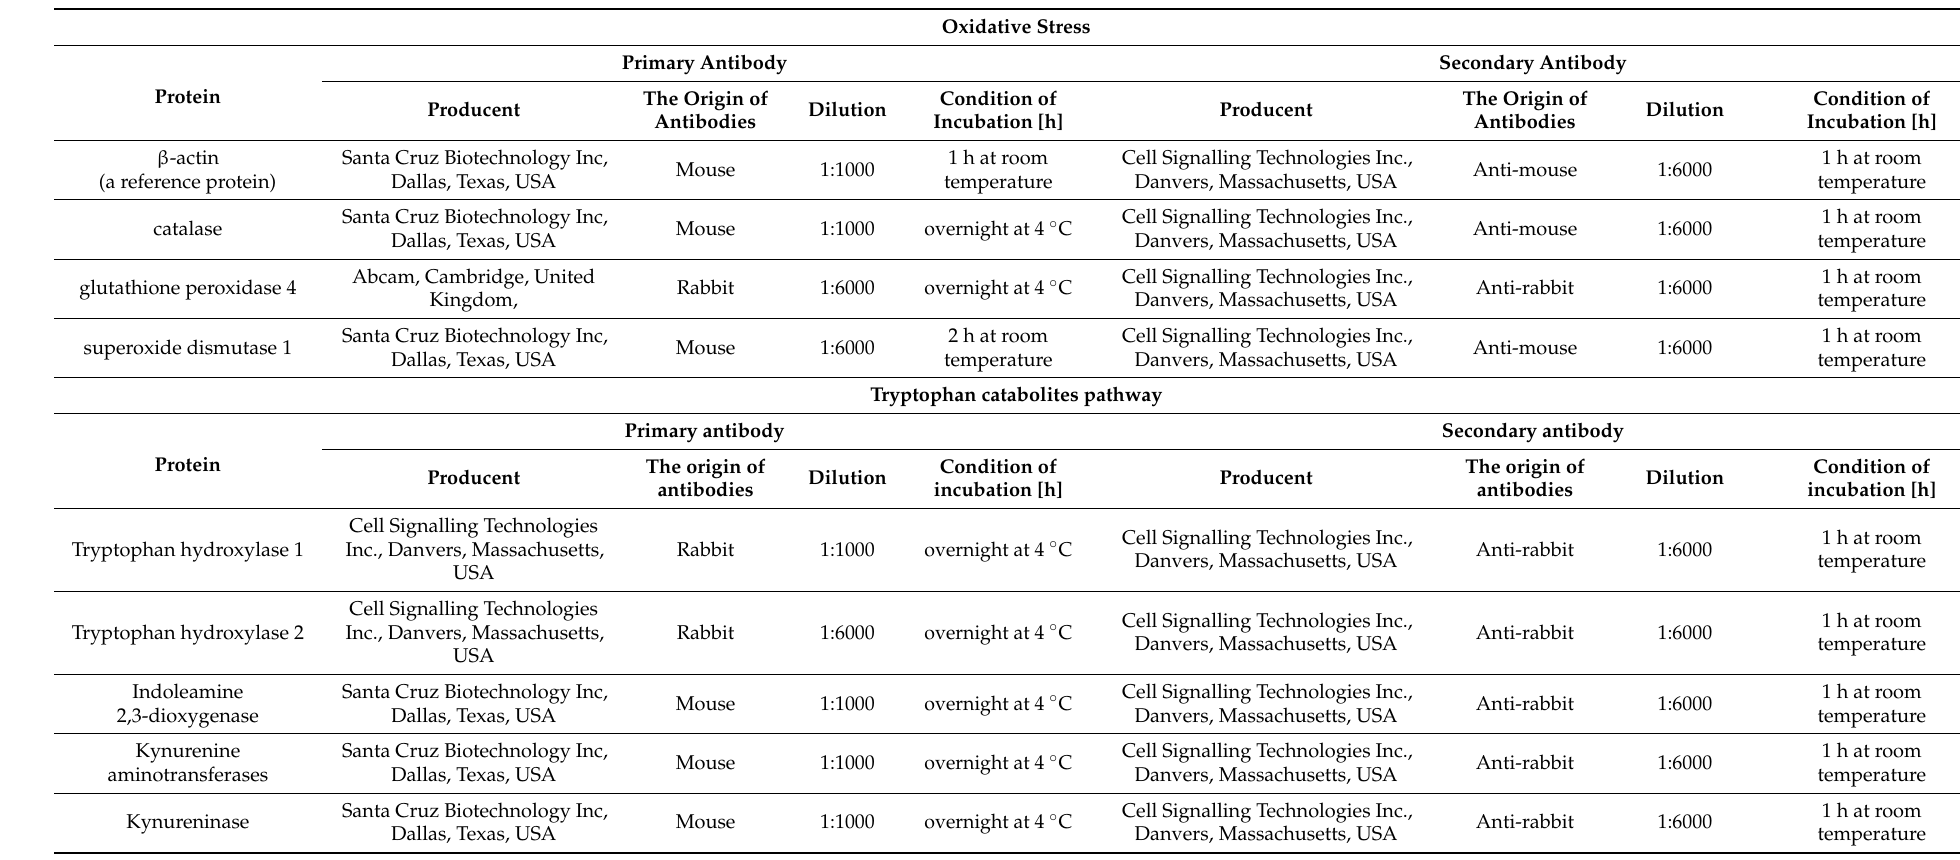
Table 3. Characteristics of antibody used in Western